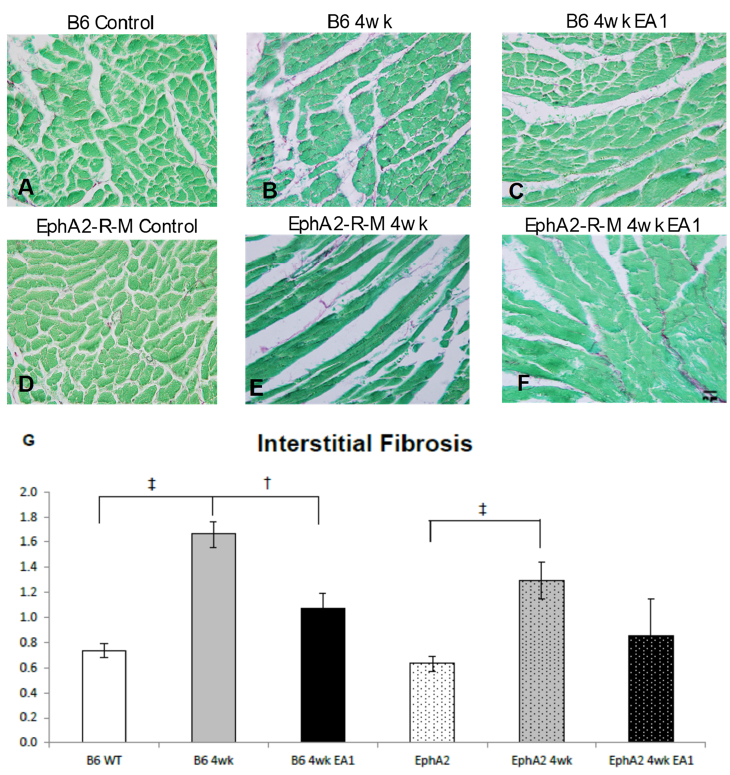
Figure 4. Interstitial Fibrosis in WT and EphA2-R-M Mouse Hearts. WT ( A – C ) and EphA2-R-M ( D – F ) images depicting interstitial fibrosis 4 weeks after infarction (stain: picrosirius red/fast green; 400x). The fibrotic response was attenuated by EA1 in WT B6 mouse hearts but not EphA2-R-M mouse hearts ( G ). B6 WT control ( n = 10), EphA2-R-M control ( n = 10), WT B6 (IgG-Fc 4w, n = 8), EphA2-R-M (IgG-Fc, n = 10), EA1-treated WT B6 ( n = 11) and ephrinA1-Fc-treated EphA2-R-M ( n = 4); † p < 0.05 and ‡ p < 0.001. Int. J. Mol. Sci. 2020 , 21 , x FOR PEER REVIEW 2.5. Cardiac Function